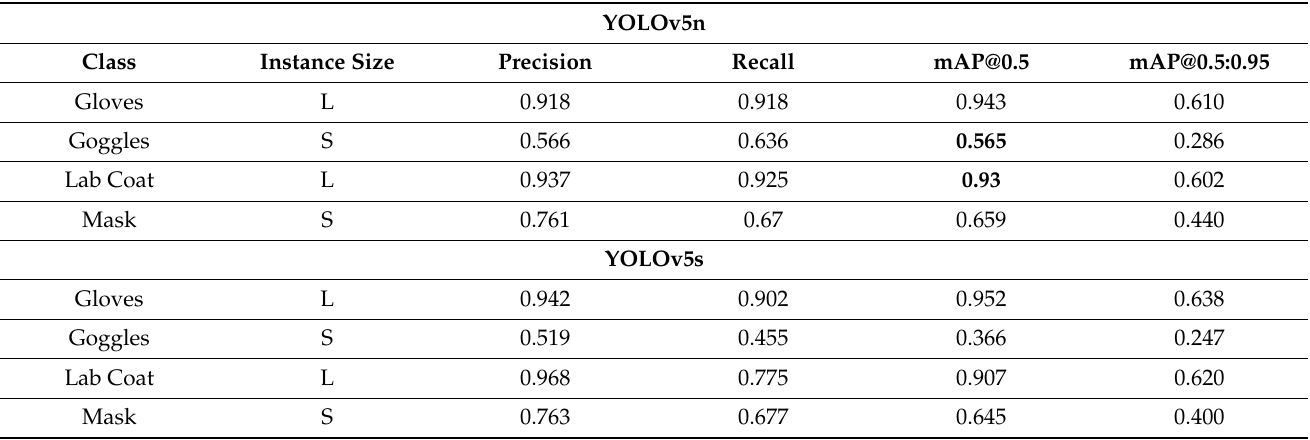
Table 2. Individual class performance of the YOLOv5 detection